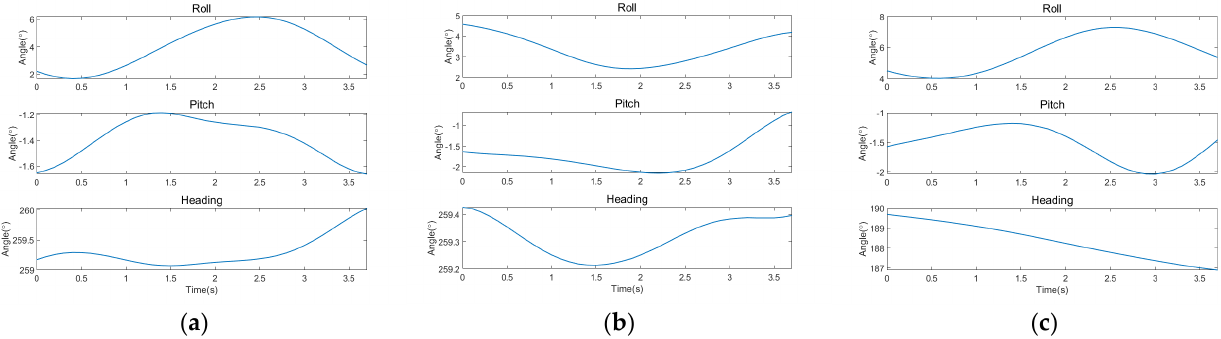
Figure 22. The ship attitude angles used for imaging. ( a ) In the unanchored state; ( b ) in the anchored state; ( c ) in the navigating state.